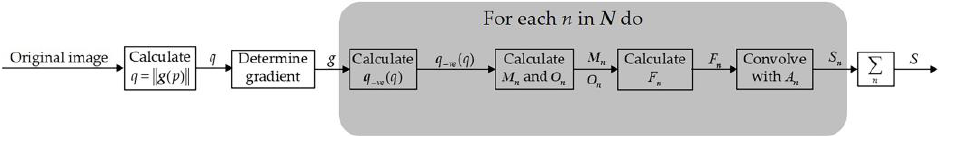
Figure 10. Comparison of results. ( a ) Original image; ( b ) when the radius is 23.5; ( c ) when the radius range is [20,27]; ( d ) when the radius range is [1,34]. Comparing Figure 10b,c with Figure 7b,c, it can be found that FGMRST can better extract and distinguish the two circle centers. However, the final symmetry map is pro- duced after combining all radial symmetry images [27]. Thus, different radii information is accumulated in the output of the transform [27]. As long as the value of input radius is